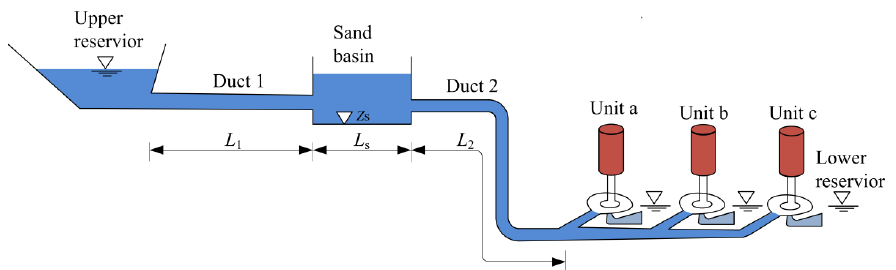
Figure 6. Schematic of the hydropower station with a sand basin. Table 1. Basic information about the hydropower